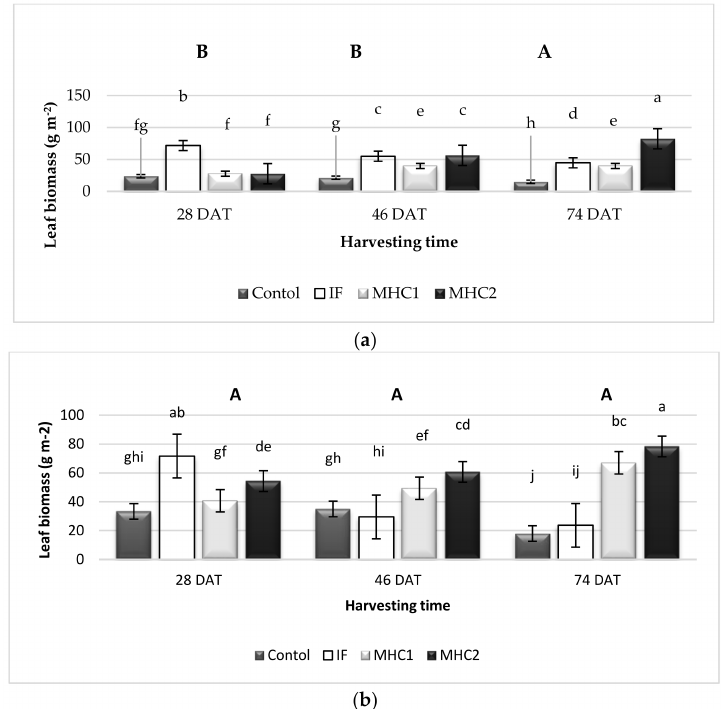
Figure 3. Effect of macadamia husk compost and inorganic fertilizer on leaf biomass (DW) during three harvest period, 28 DAT = Harvest 1, 46 DAT = Harvest 2, Harvest 3 = 74 DAT, in 2018 ( a ) and 2019 ( b ). Different small letters indicate significant differences between fertilizer levels and harvest time ( p < 0.01), and different capital letters indicate significant differences between harvest time ( p < 0.01). Table 2. Effect of macadamia husk compost and inorganic fertilizer on root biomass (DW), root length, and root to shoot ratio (DW) in 2018 and 2019.